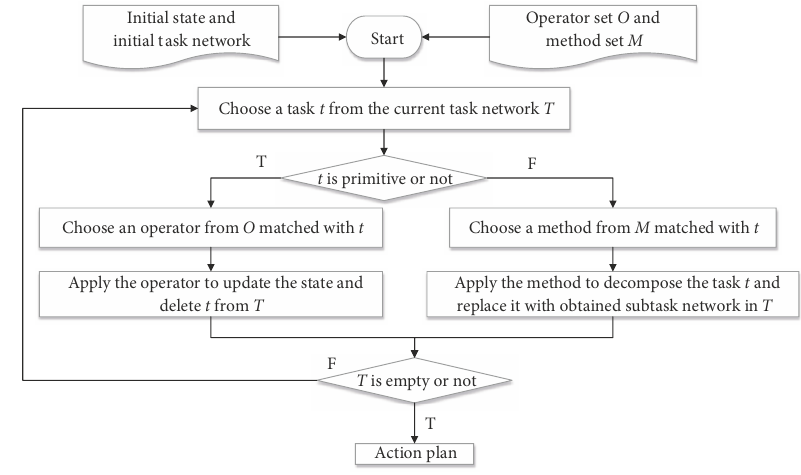
Figure 1. HTN planning